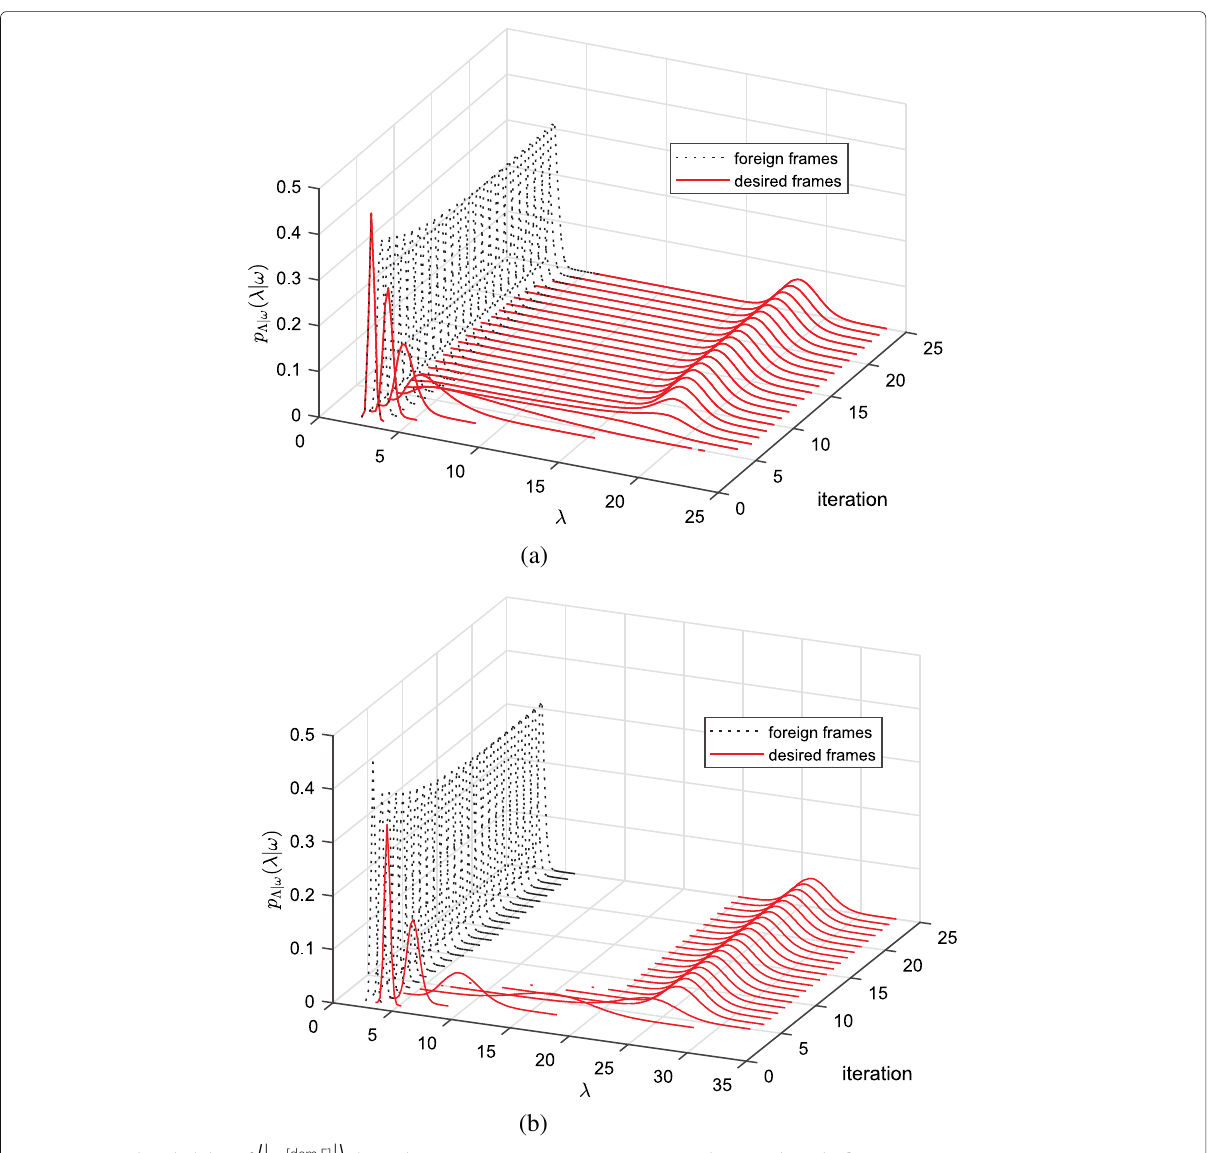
Fig. 3 Empirical probability of